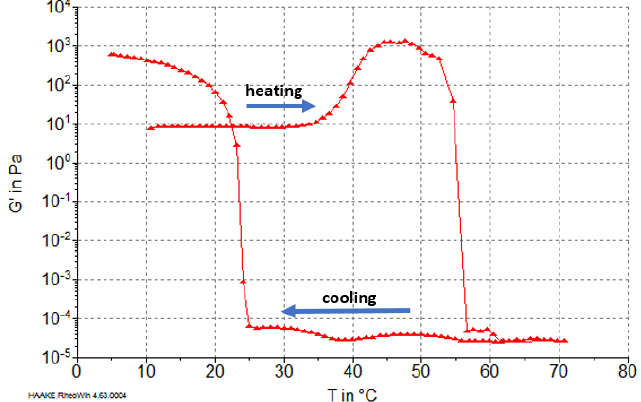
Figure 3. Changes in the G ’ value of atelocollagen fibers (from cartilage after pretreatment with NaCl).